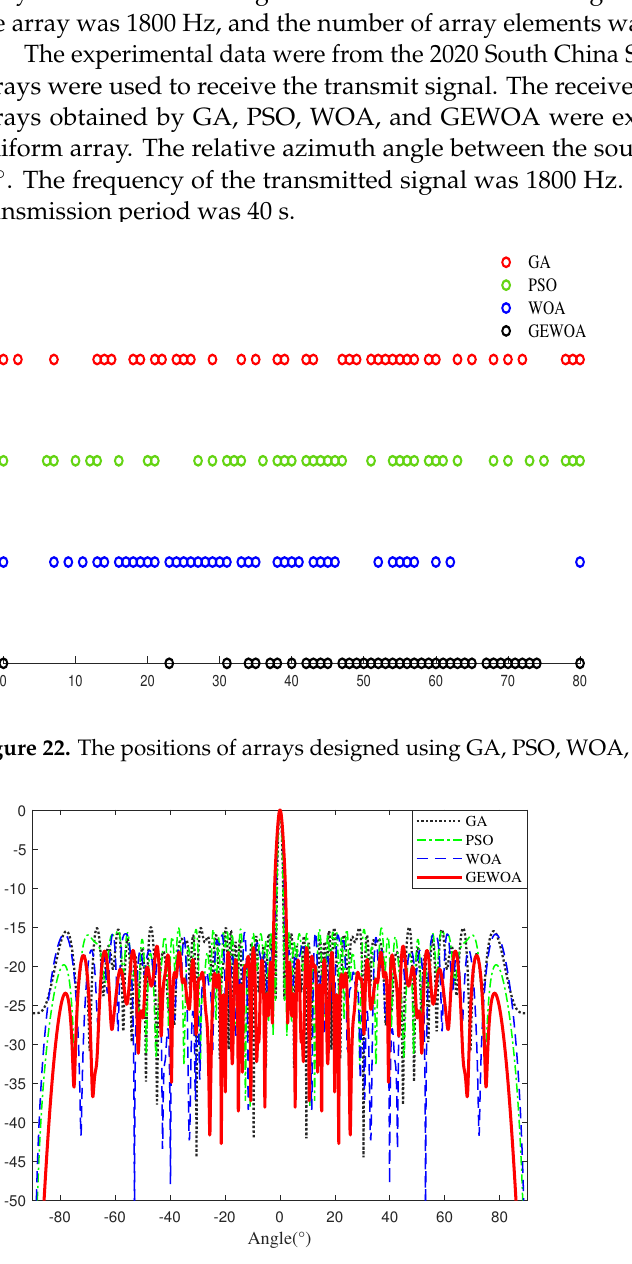
Figure 23. Beampatterns of the on-grid arrays (40-element) designed using GA, PSO, WOA, and